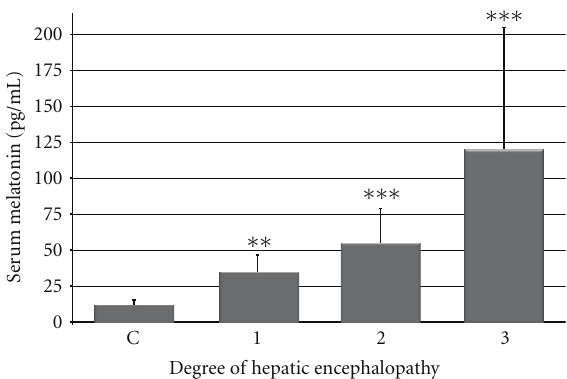
Figure 1: Serum melatonin levels in healthy subject (C) and in cirrhotic patients with di ff erent (1, 2, 3) degree of hepatic enceph- alopathy—according to West-Haven Score. ∗∗ P < 0 . 01, ∗∗∗ P < 0 . 001.